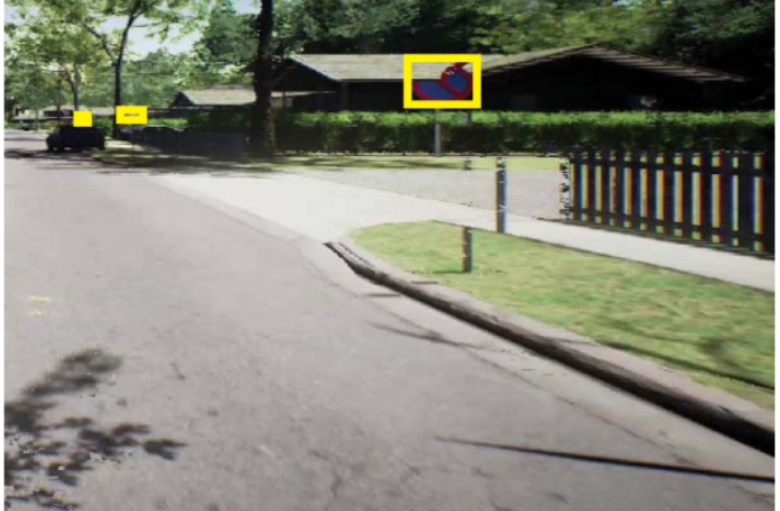
Figure 19. Failure case of the proposed method by Kamal et al. [67]. The proposed method fails if traffic signs are placed at different places. Adapted with the permission from [67]. Copyright 2019